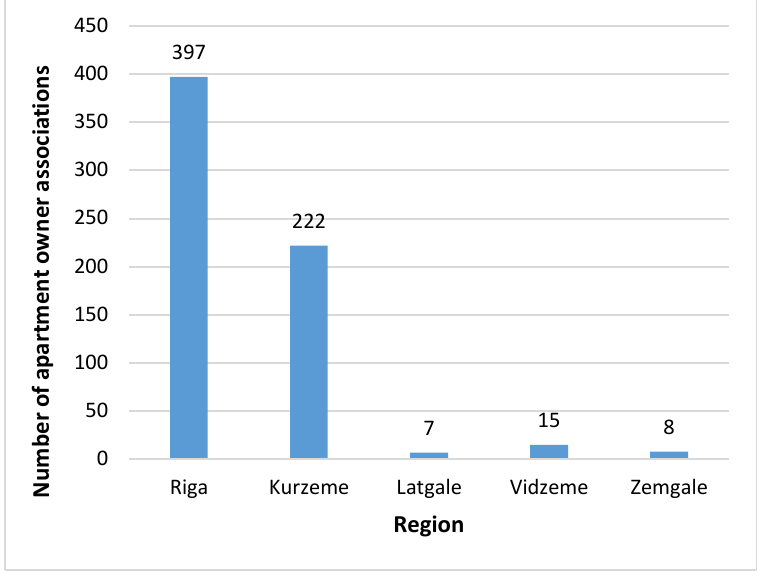
Fig. 2. The number of apartment owner associations in Latvia [developed by the